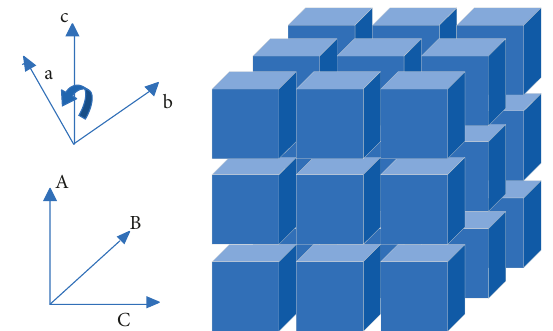
Figure 2: The C3D8R unit